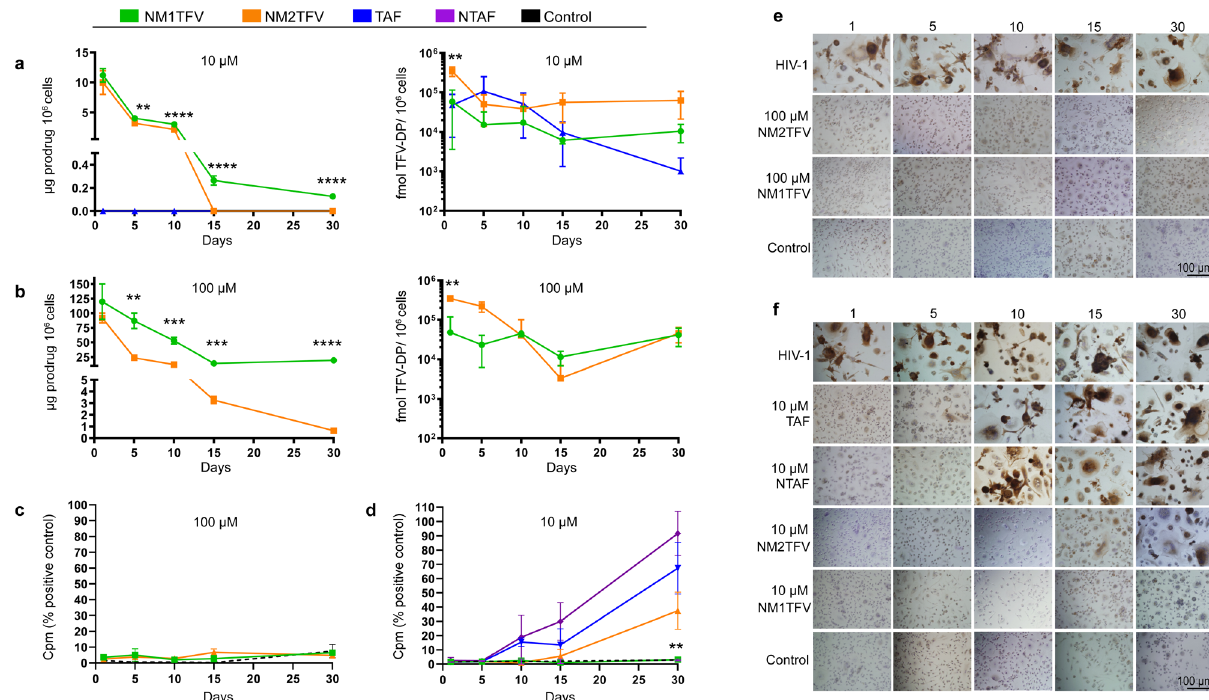
Fig. 4 Long-term cell nanoparticle interactions. Following a 10 µ M (** P = 0.0026, **** P < 0.0001 NM1TFV vs. NM2TFV prodrug; ** P = 0.0096 NM1TFV vs. NM2TFV TFV-DP) or b 100 µ M treatments of NM1TFV (green), NM2TFV (orange) or TAF (blue) (** P = 0.001511, *** P = 0.000326, *** P =